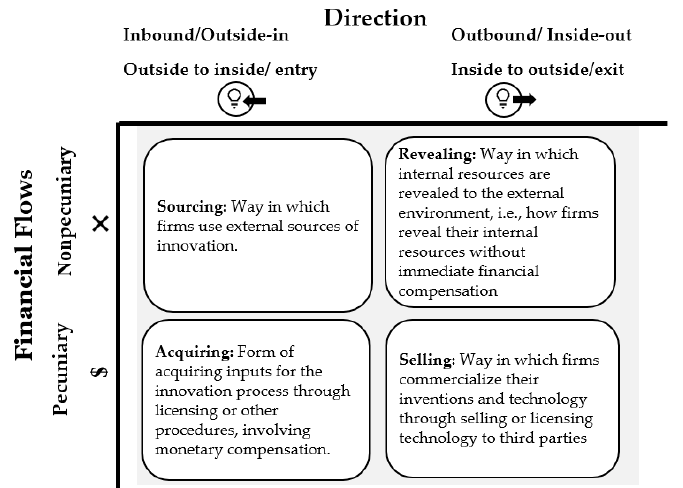
Figure 1. Operational model of forms of inbound and outbound practices. Source: Own elaboration, from Chesbrough and Brunswicker